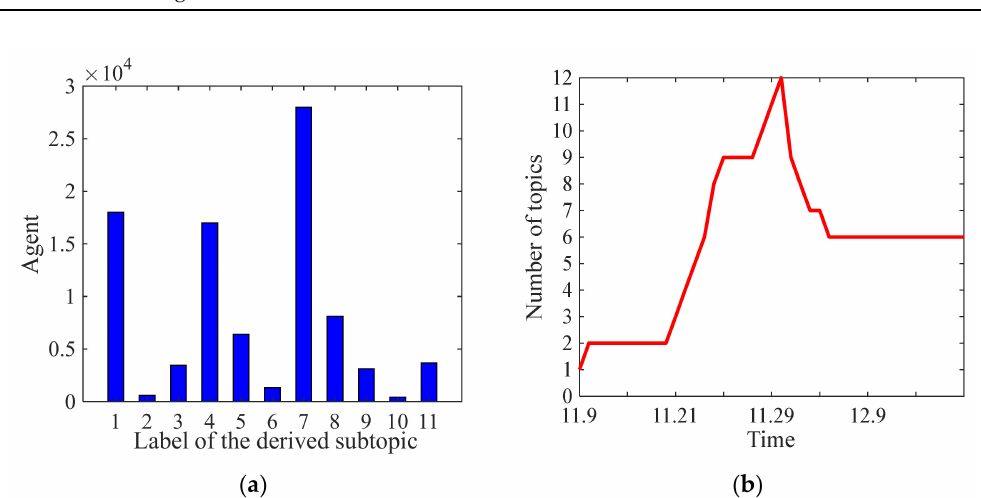
Figure 32. Simulation of derived subtopics for this public opinion. ( a )The numberof agents discussing derived subtopics. ( b ) Change inthe number of